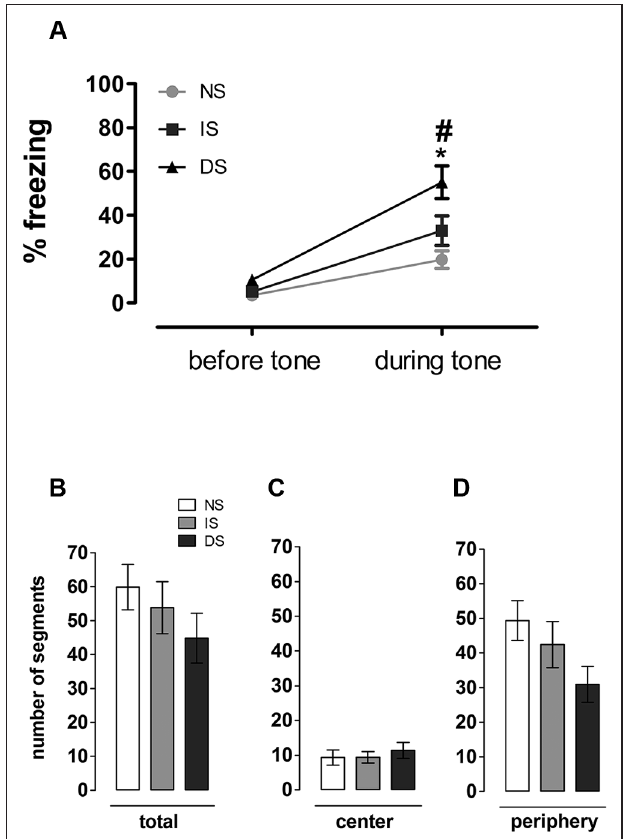
FIGURE 4 | Open field analyzes . (A) Expression of fear in a mildly aversive situation. Percentage of time in freezing before and during tone presentation. Number of (B) total (C) central and (D) peripheral segments traveled. NS = no-shock group ( n = 9); IS = immediate shock group ( n = 10); DS = delayed shock group ( n =